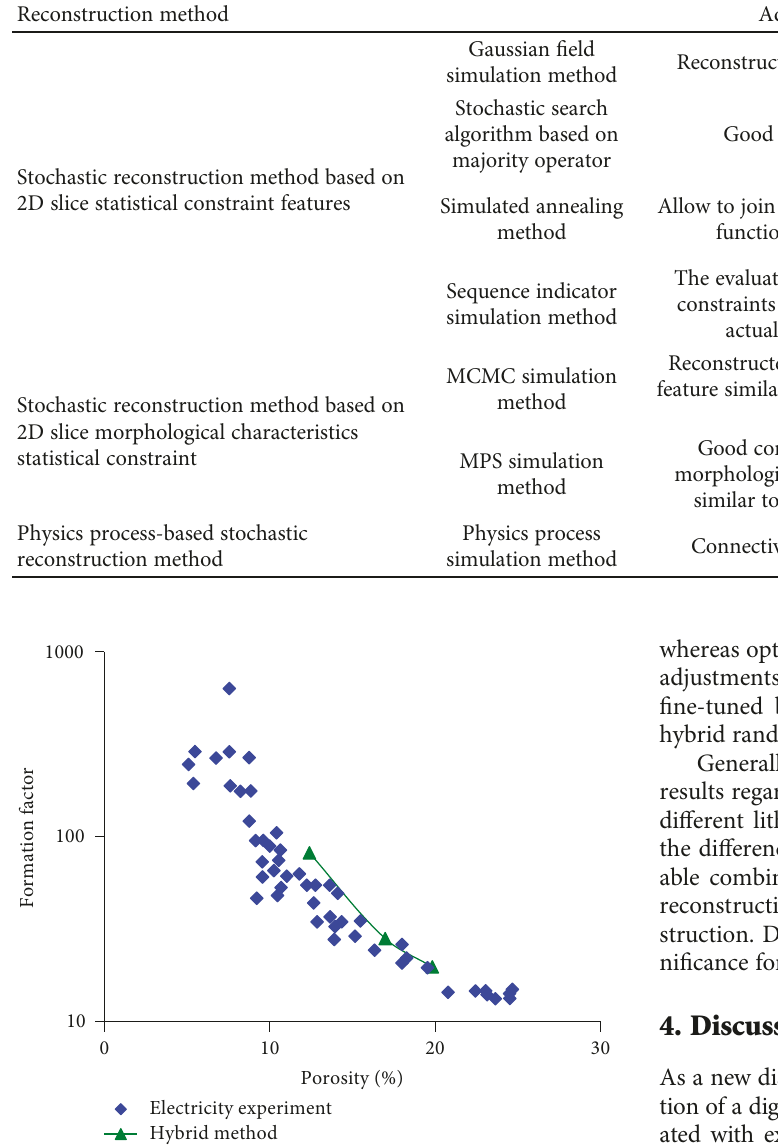
Figure 14: Compared with the experimental data, the three- dimensional digital core reconstructed by the hybrid method has good correspondence with the experimental results in the high- porosity part. The three-dimensional digital core constructed by this method is more realistic. Figure reprinted from